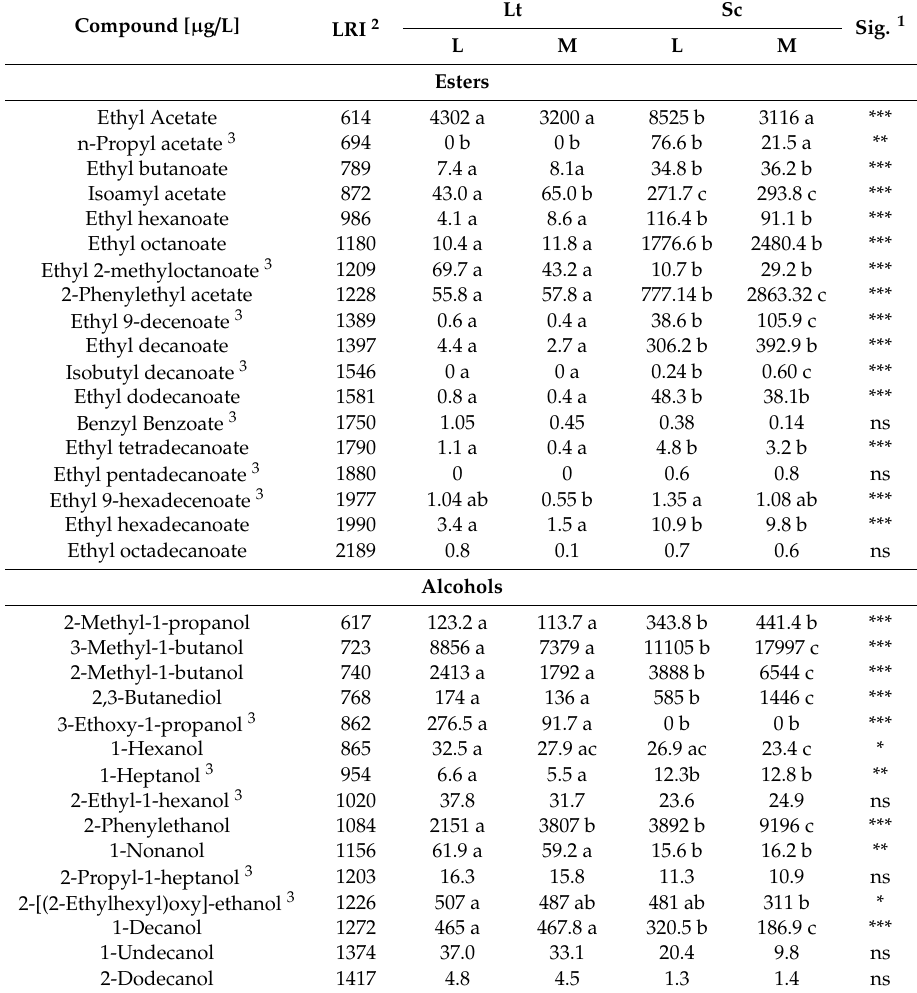
Table 4. Volatile compounds in beer brewed with Marynka (M) or Lubelski (L) hop pellets, fermented by L. thermotolerans (Lt) or S. cerevisiae